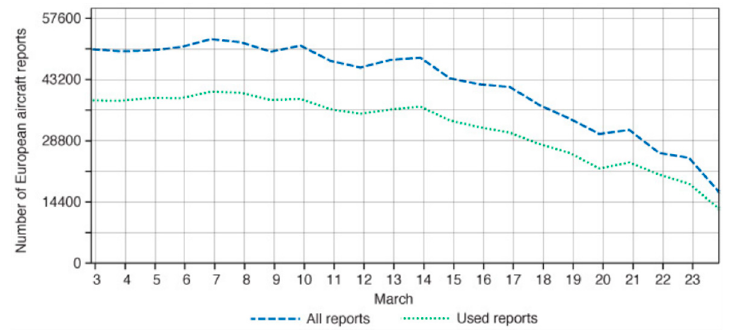
Figure 9. Number of daily aircraft reports over Europe received and used at ECMWF. Source: https://www.ecmwf.int/en/about/media-centre/news/2020/drop-aircraft-observations-could-have- impact-weather-forecasts